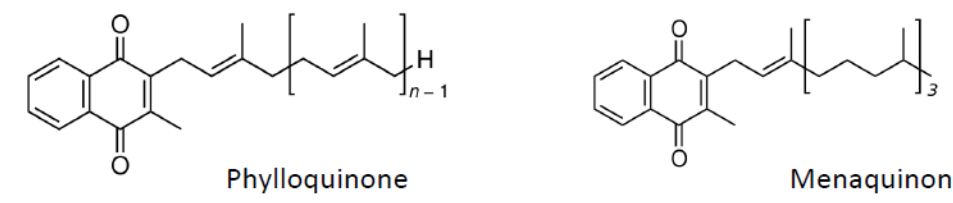
Figure 4. Vitamin K